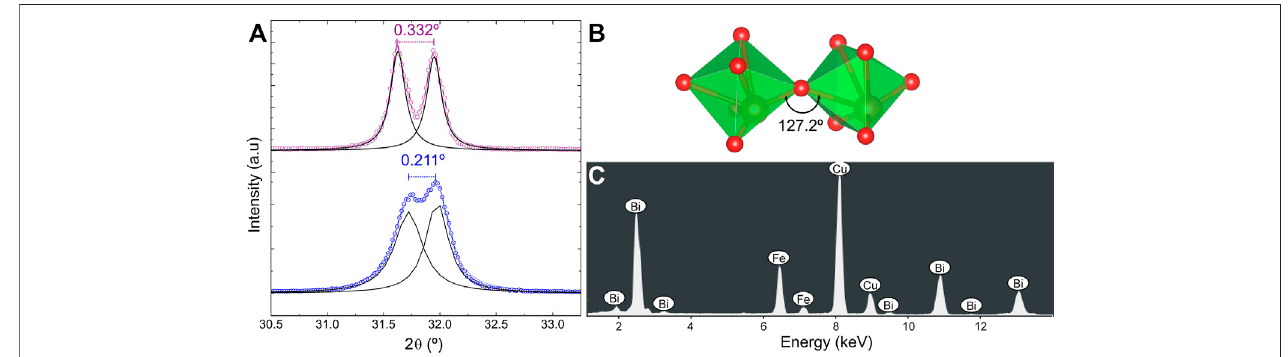
FIGURE 3 | (A) XRD peaks corresponding to the (110) (right) and (104) (left) crystallographic planes for BiFeO 3 samples prepared by the conventional ceramic method (purple pattern) and the combined mechanochemical − thermal route (blue pattern). (B) The neighboring FeO 6 octahedra in the crystal lattice of the as-prepared